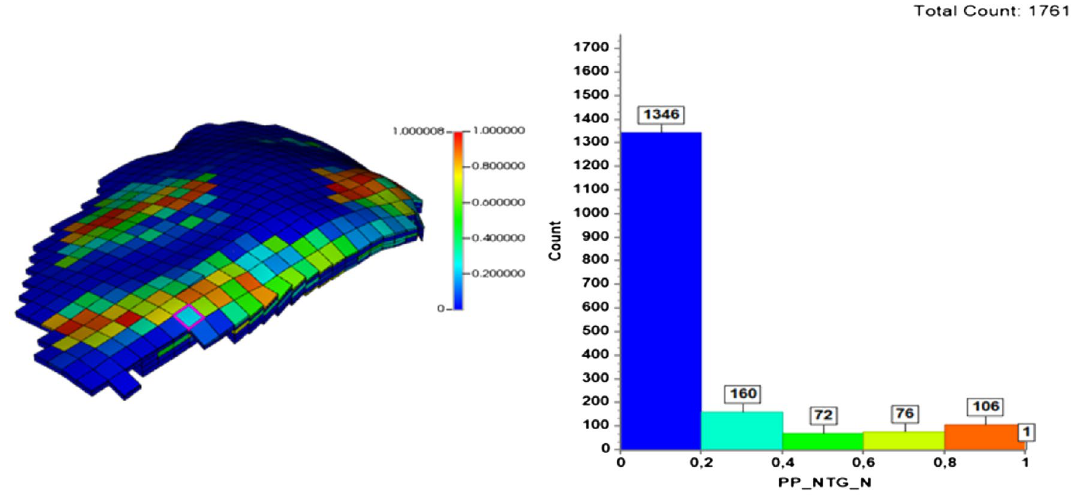
Fig. 5 Normalized PP i map (left) and its histogram for the active blocks